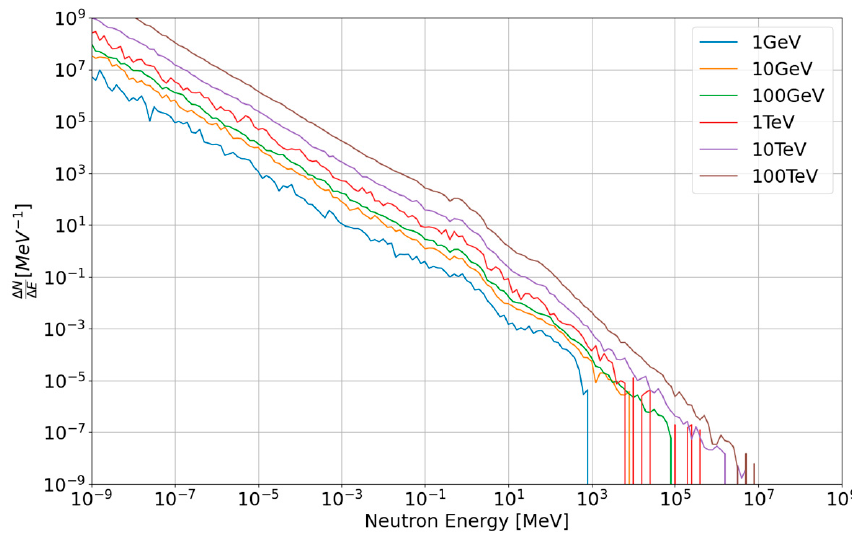
Figure 10. Spectrum of secondary neutrons for one incident proton at 18 km of altitude. Applying Equation (1) to the primary spectrum of a given location and a given date, we computed the spectra of secondaries. In Figure 11a, we present the contribution of each part of the primary proton spectrum in the production of secondary neutrons at 18 km based on the primary particle population given in Figure 8. According to Figure 10, the number of secondary particles per primary proton increases with incident energy. However, because the flux of primary ions decreases with energy, we observe in Figure 11 that the primary proton energy that contributes the most to the secondary spectrum at 18 km is 10 GeV. In addition, the 100 TeV energy also contributes a lot to the neutron spectrum, not because of their abundance but because of their high energy, which allows triggering much more secondary particle generation. This is a crucial point, since it shows that we cannot neglect the contribution of very high-energy primary particles, which represent at least of 30% of the total spectrum. Moreover, the lower the altitude is, the higher the impact of the energy. In Figure 11b, we plotted the spectrum of secondary neutrons as a function of the energy of the incident proton at 7 km. In this case, we now observe a higher impact of the 100 TeV compared to 10 GeV, because the denser atmosphere has a greater impact on the lower-energy particles generated by the 10 GeV primary proton. The secondary particles generated by a 10 GeV have a lower energy than the ones from 100 TeV, and then are easily stopped by the atmosphere. The denser the atmosphere, the more energy the secondaries lose and the faster they stop. Finally, there is a very small contribution, less than 1%, of secondaries generated by the 1 GeV primary protons at 7